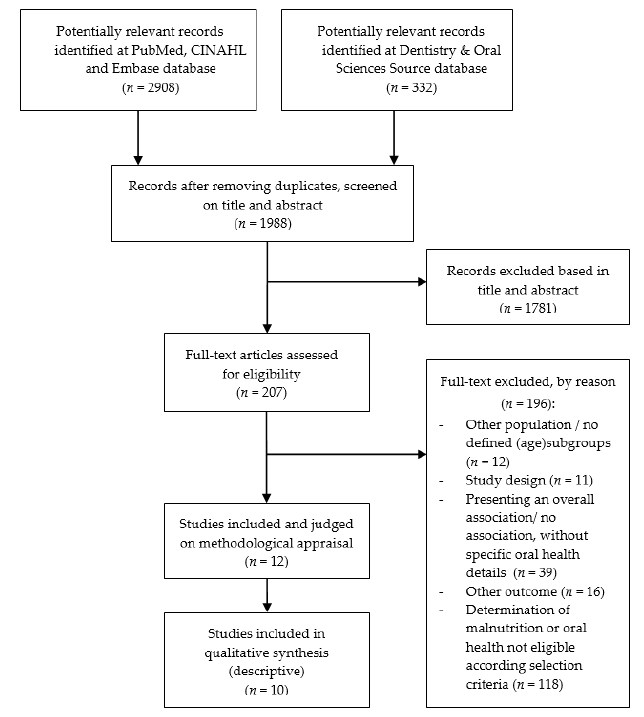
Figure 1. Flow chart of study selection.